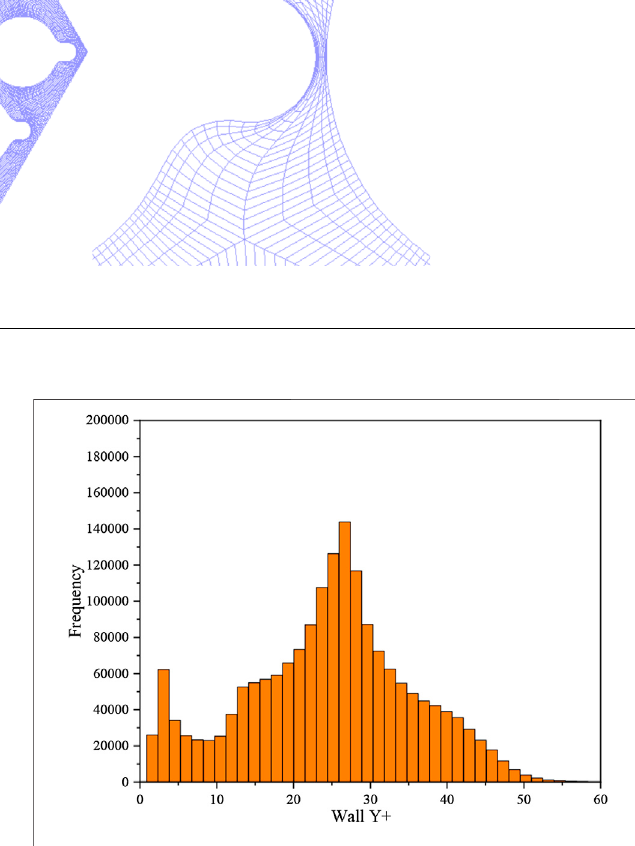
FIGURE 12 | Number of cells with wall y +